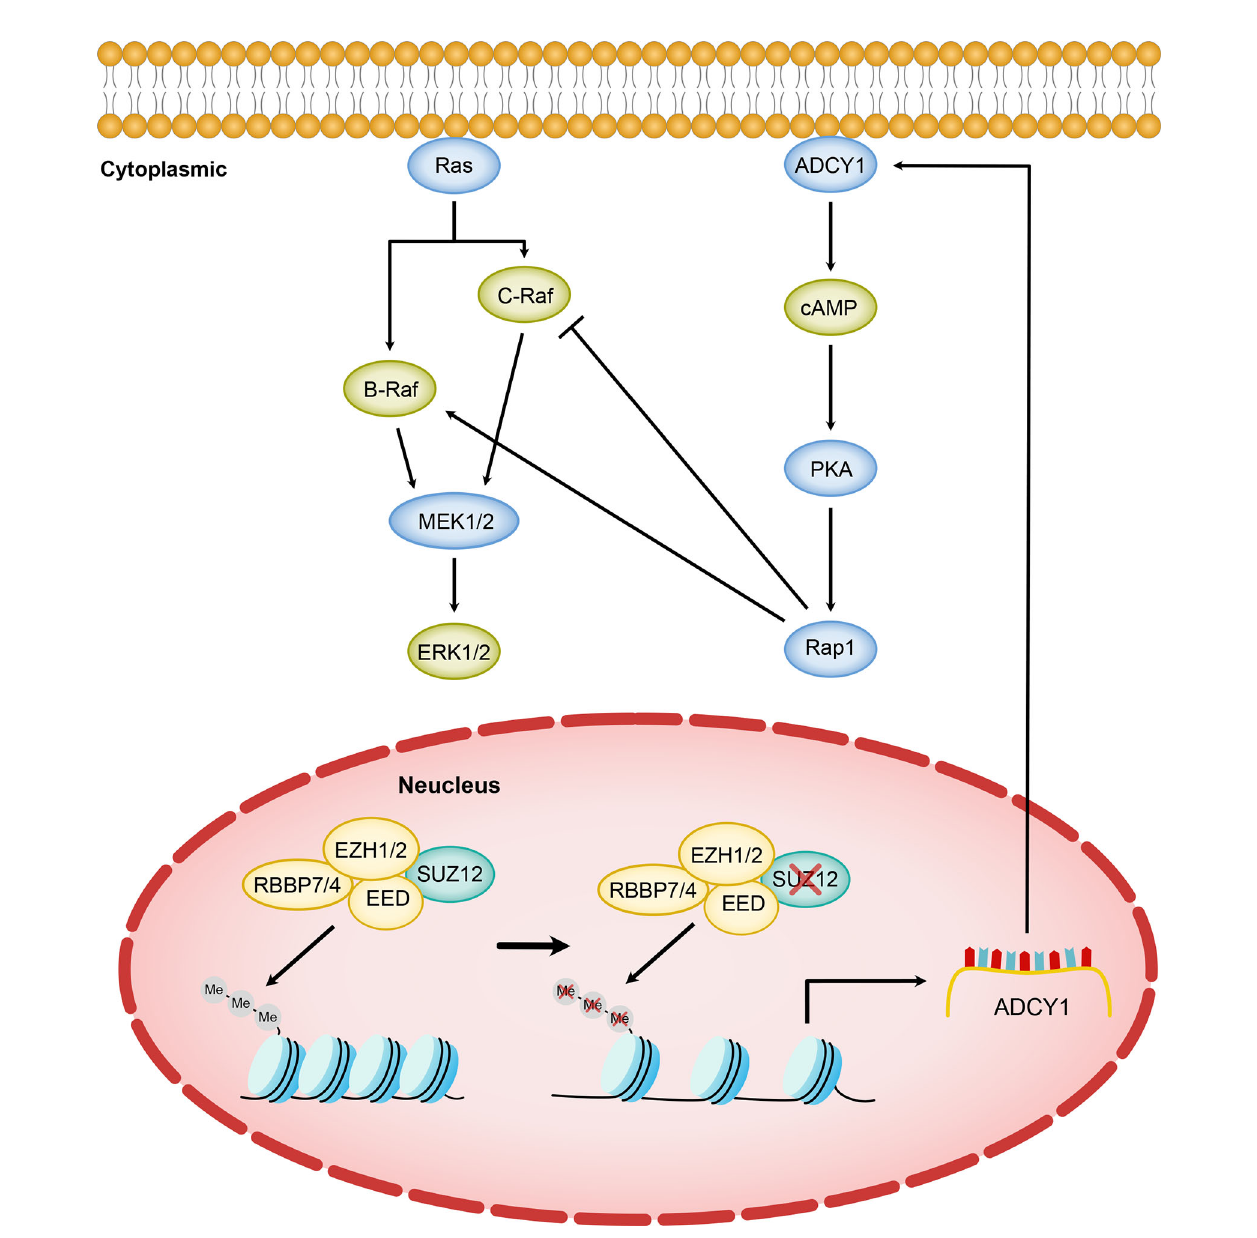
FIGURE 7 | Model of SUZ12 loss amplifying the RAS/ERK pathway via ADCY1. Diminished transcriptional repression of ADCY1 by PRC2 after SUZ12 deletion ampli fi es the RAS signaling pathway through cascade activation of PKA, Rap1 and B-Raf. Different Raf isoforms may play different roles in the p-ERK activation